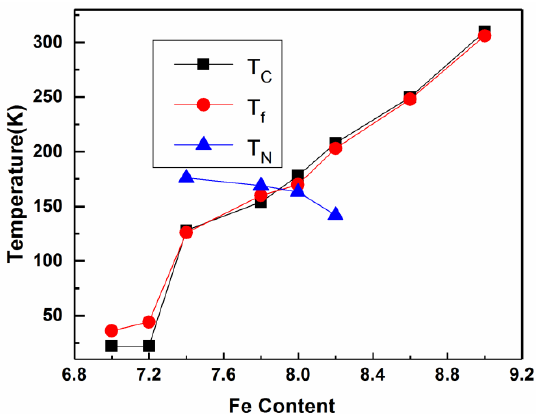
Figure 4. The magnetic phase diagram of ErFe x Mn 12−x (7.0 ≤ x ≤ 9.0) series alloys.